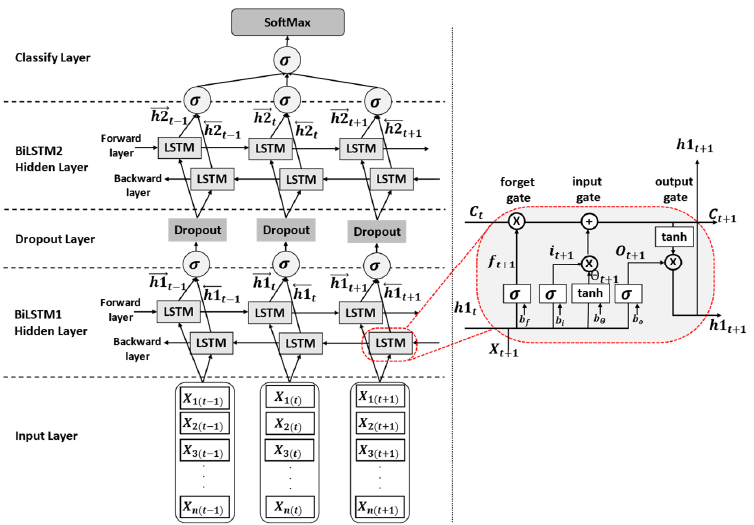
Figure 12. Two ‐ layer BiLSTM neural network . Figure 12. Two-layer BiLSTM neural